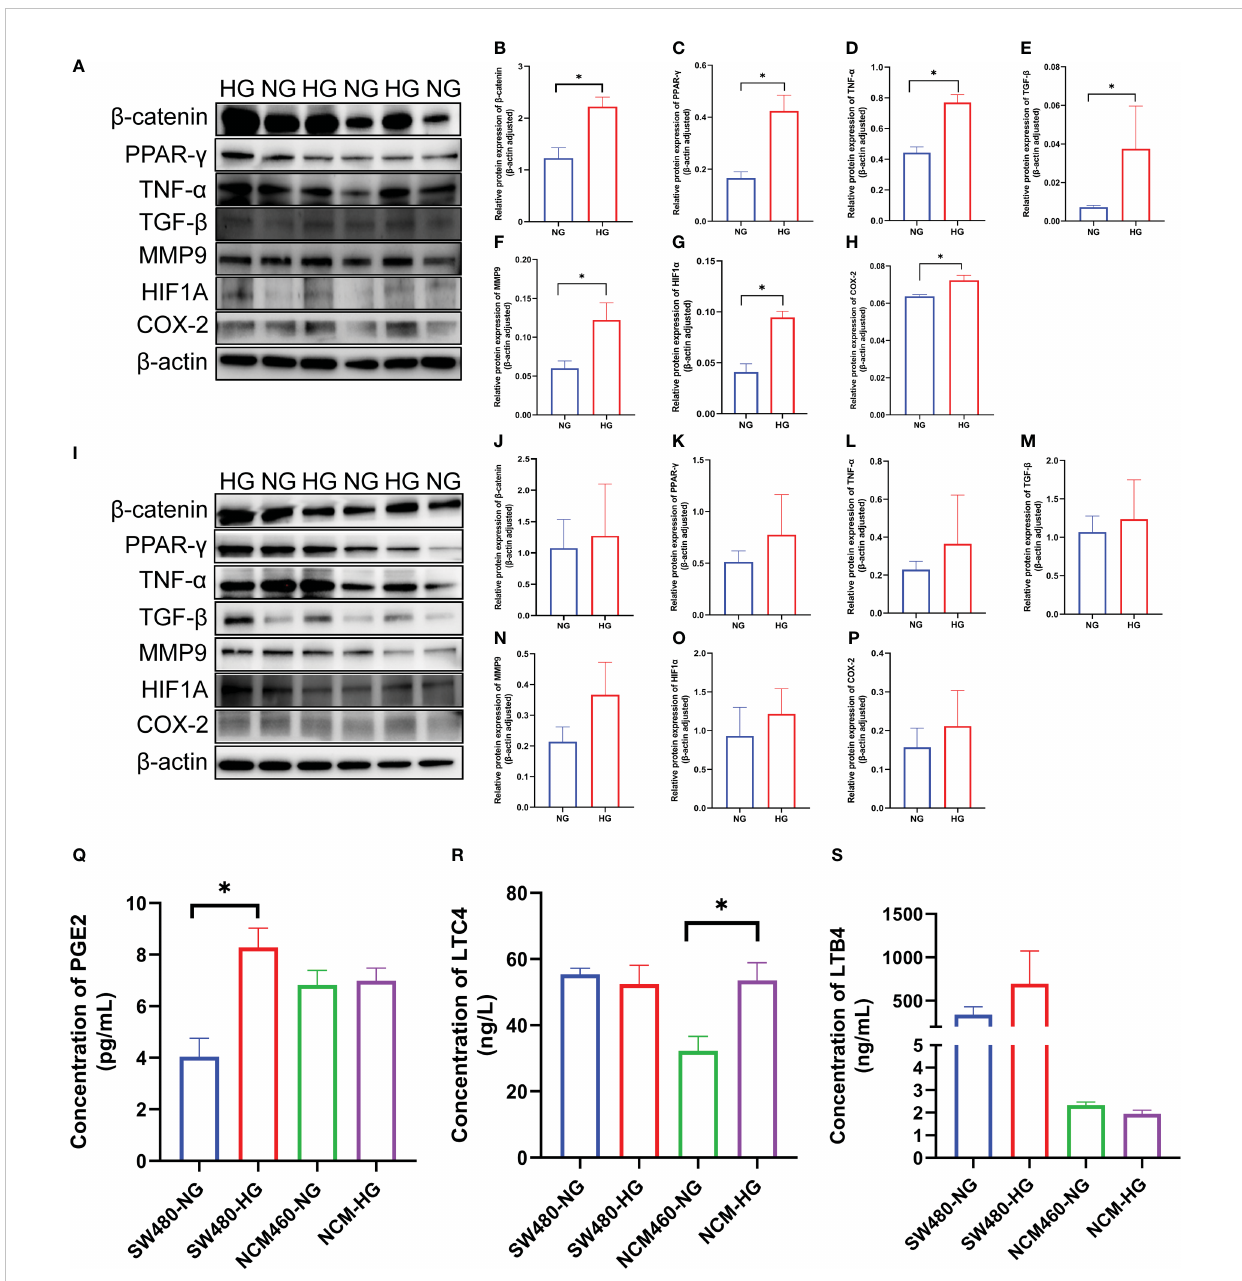
FIGURE 7 Veri fi cation of the seven DCRGs and arachidonic acid pathway in COAD. (A – H) Western blots of the seven DCRGs in the SW480 cells treated with NG or HG. (I – P) Western blots of the seven DCRGs in the NCM460 cells treated with NG or HG. (Q – S) ELISA of PCGE2 , LTC4 , and LTB4 in the SW480 and NCM460 cells treated with NG or HG. * P < 0.05 compared to controls. HG, high glucose; NG, normal